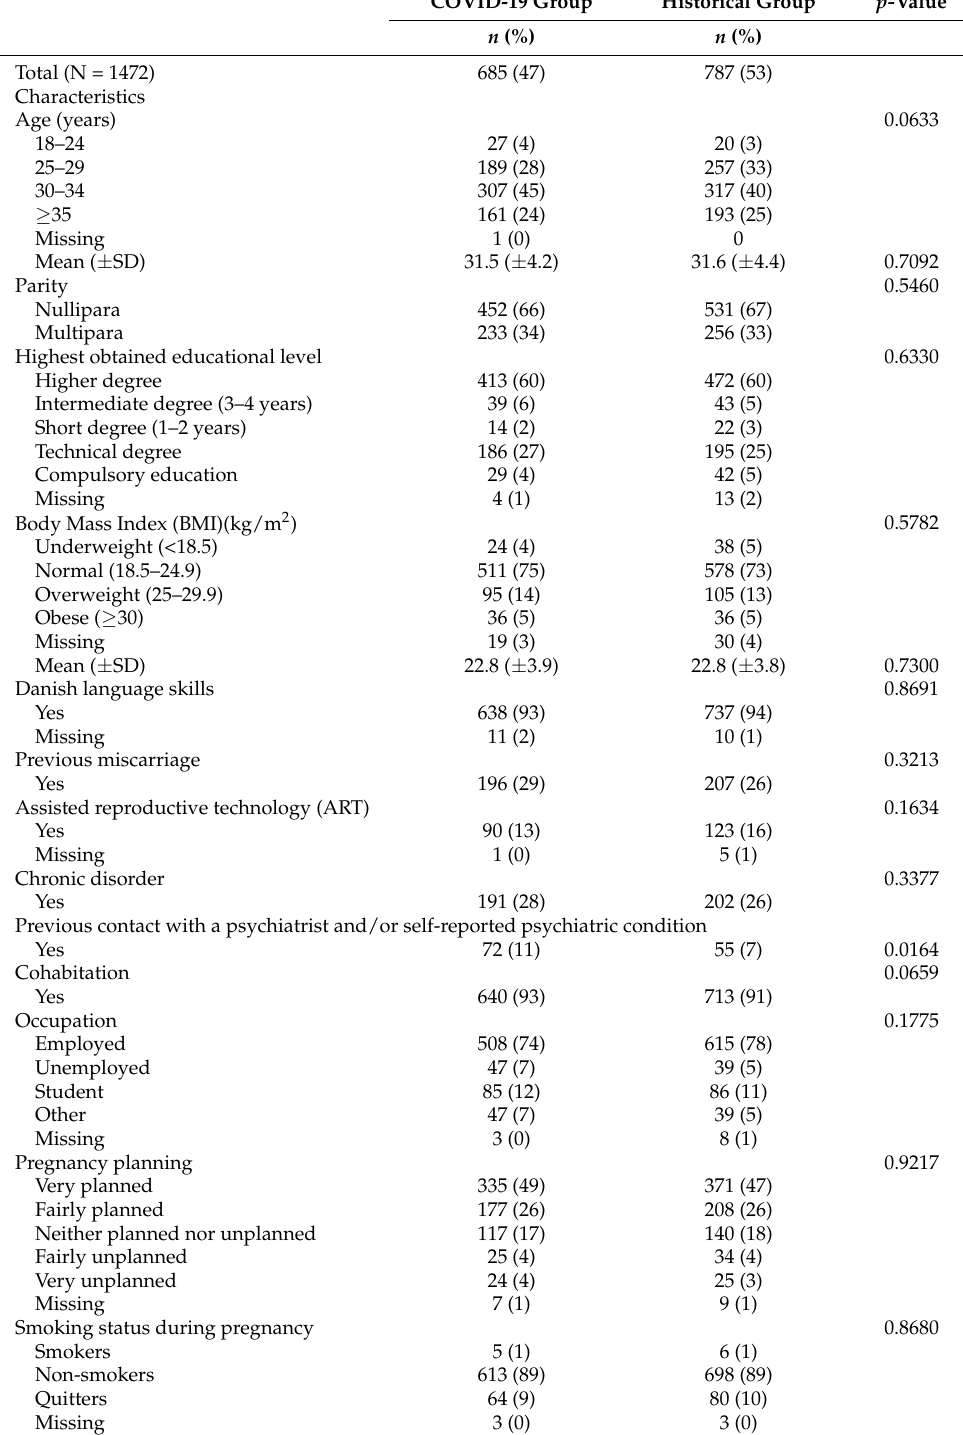
Table 1. Characteristics of the COVID-19 group and the Historical